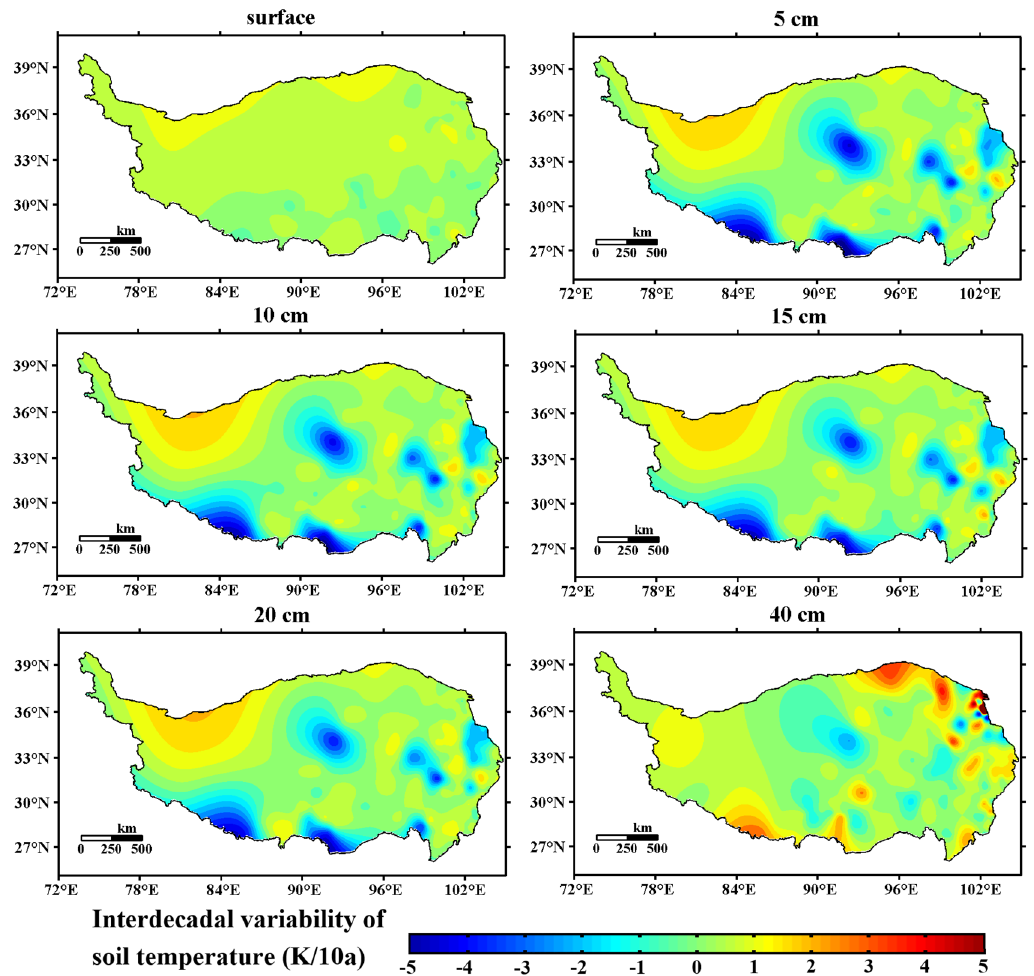
Figure 6. Distribution of interdecadal variability in ST in shallow soil on the Qinghai-Tibet Plateau from 1981 to 2020 (unit: K/10 a, α = 0.01 , Software: MATLAB 2014, https:// ww2. mathw orks. cn/ produ cts/ matlab.